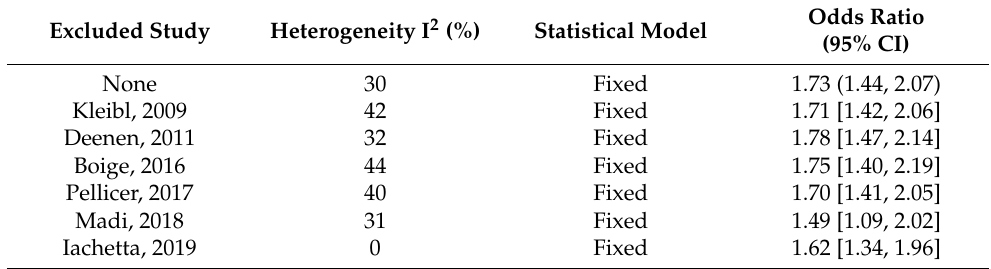
Table 2. Sensitivity analysis by sequentially excluding each study from the meta-analysis.